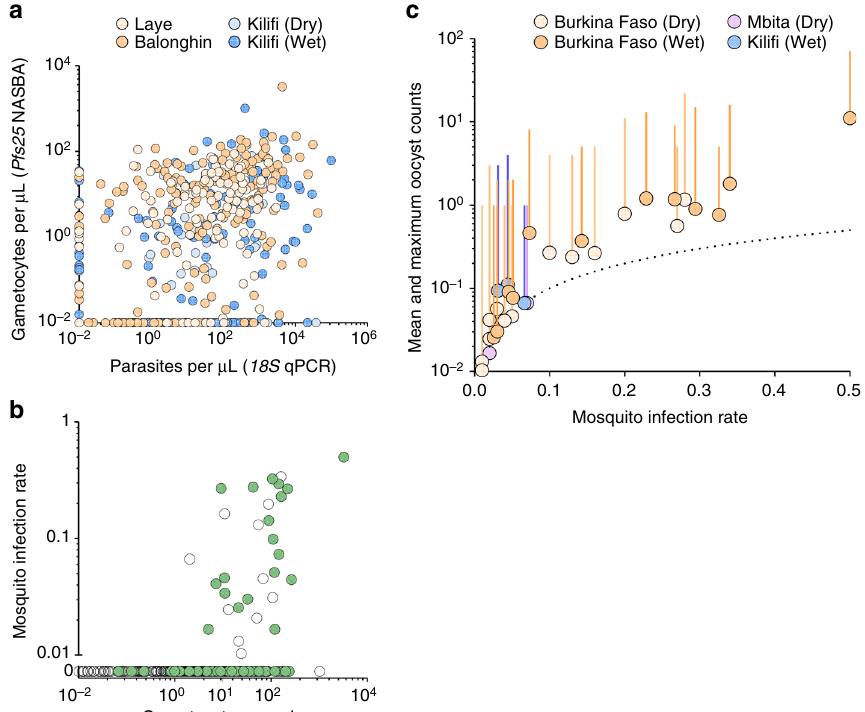
Fig. 3 Associations between gametocyte and parasite densities, gametocyte density and infectivity, and mosquito infection prevalence and infection burden. In a , the association between gametocyte and parasite densities is shown; the y axis is on log 10 scale and parasite ( 18S qPCR) and gametocyte ( Pfs25 mRNA quantitative nucleic acid sequence-based ampli fi cation (QT-NASBA)) densities were set to 0.01 parasites (or gametocytes) per µ L for negative samples to be included in this panel. In b , the proportion of mosquitoes infected in individual feeding experiments ( y axis) and gametocytes densities ( x axis) are shown. Data from all surveys are presented: gametocytes densities were quanti fi ed by Pfs25 mRNA QT-NASBA in samples collected in Burkina Faso and Kili fi , and by microscopy for Mbita participants. Green circles correspond to samples with patent gametocytes. Both the x axis and the segment of the y axis that ranges from 0.01 to 1 are in log 10 -scale. Individuals who did not infect mosquitoes are presented in a separate segment of y axis that only includes the 0 y coordinate. One infectious individual from Mbita who infected 4/60 mosquitoes had no gametocytes detected by microscopy and no available sample for molecular assays and is therefore not represented in the graph. In c , mean and maximum (vertical line) oocyst counts per assay in experiments with at least one mosquito infection are presented. The dotted line represents the hypothetical situation if all infected mosquitoes in an experiment would have exactly one oocyst. In b , c , feeding experiments where participants had evidence of non-falciparum malaria infections